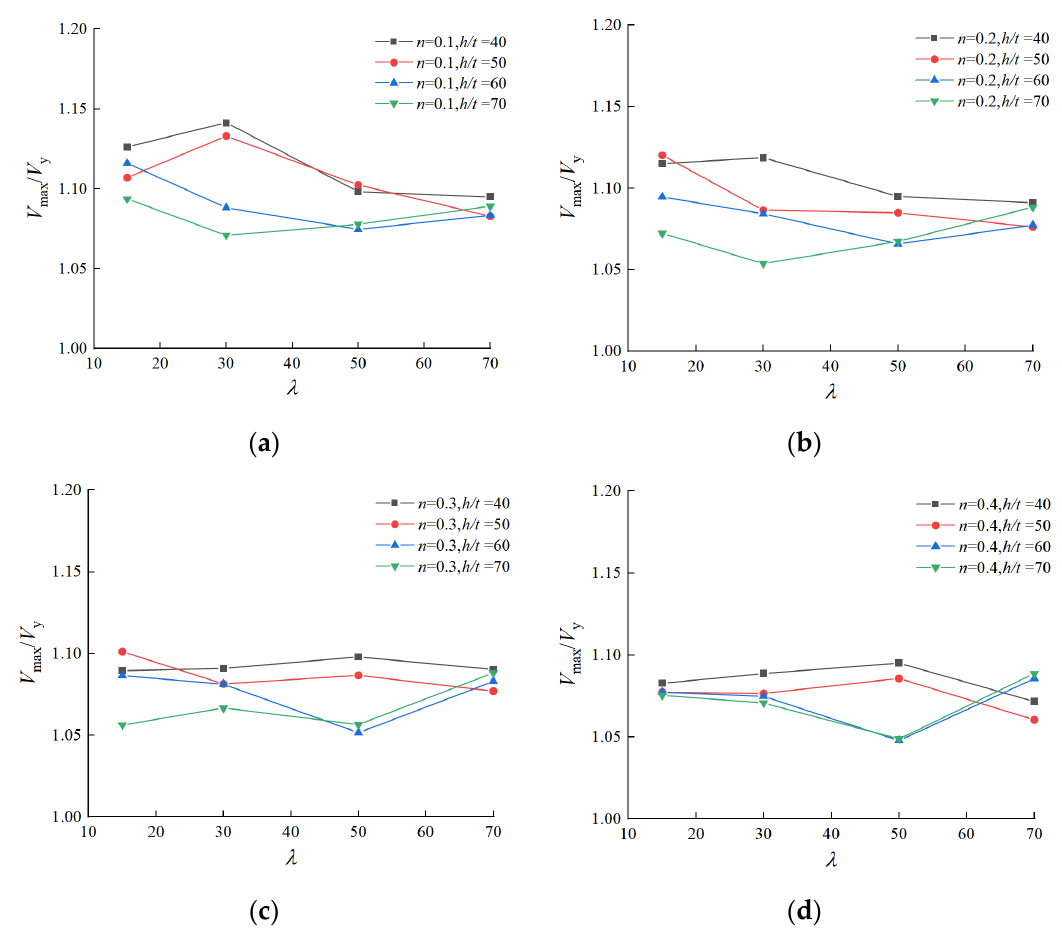
Figure 19. The effect of λ on V max / V y . ( a ) n = 0.1; ( b ) n = 0.2; ( c ) n = 0.3; ( d ) n =